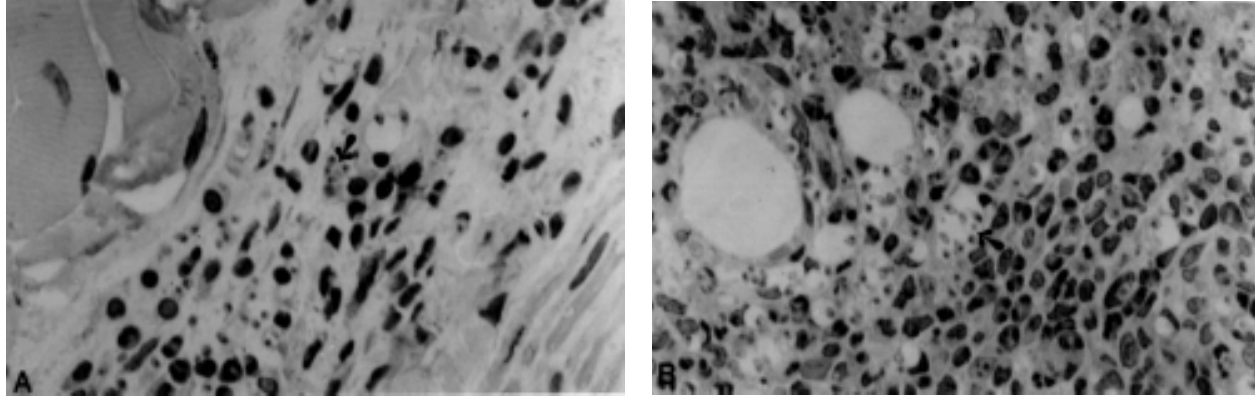
Figure 2 - Histopathology of skin lesions from control or NK-depleted mice infected with Leishmania ( L. ) amazonensis. Hematoxylin and eosin. Magnification, 40X. A , Mixed inflammatory infiltrate with few parasites is shown in control BALB/c mice. B , Mixed inflammatory infiltrate with more parasites is shown in NK-depleted BALB/c